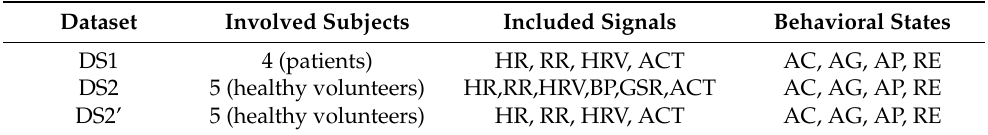
Figure 1 . Multi-sensor setup for the acquisition of physiological and neurovegetative parameters. Table 1 . Overview of the collected datasets.